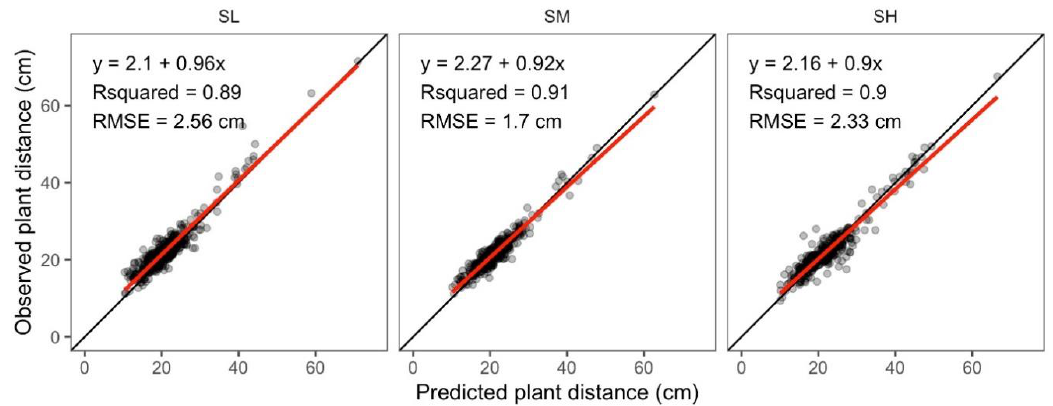
Figure 3. Estimated vs. measured plant-to-plant distance in three yield stability zones.